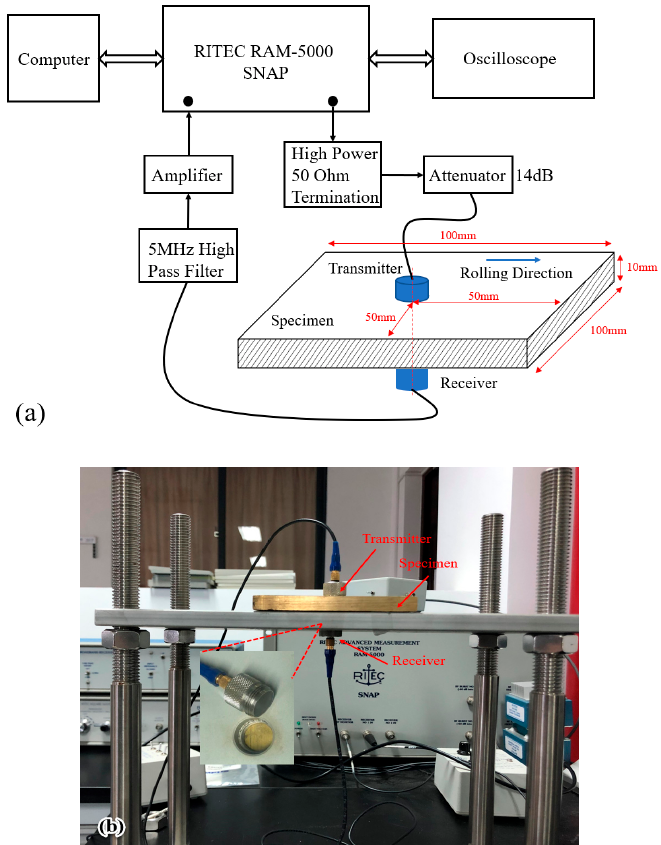
Figure 1. Experimental setup: ( a ) Block diagram of the ultrasonic measurement system, ( b ) picture of the specimen and experiment.